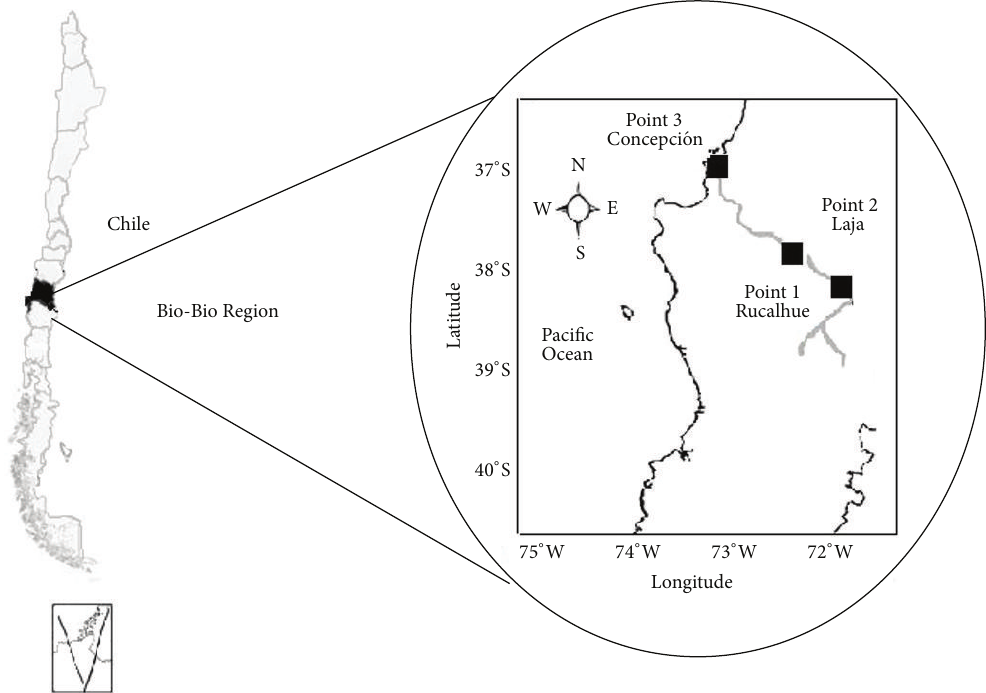
Figure 1: Geographical location of water sampling points from Bio-Bio Rivers, VIII Region,